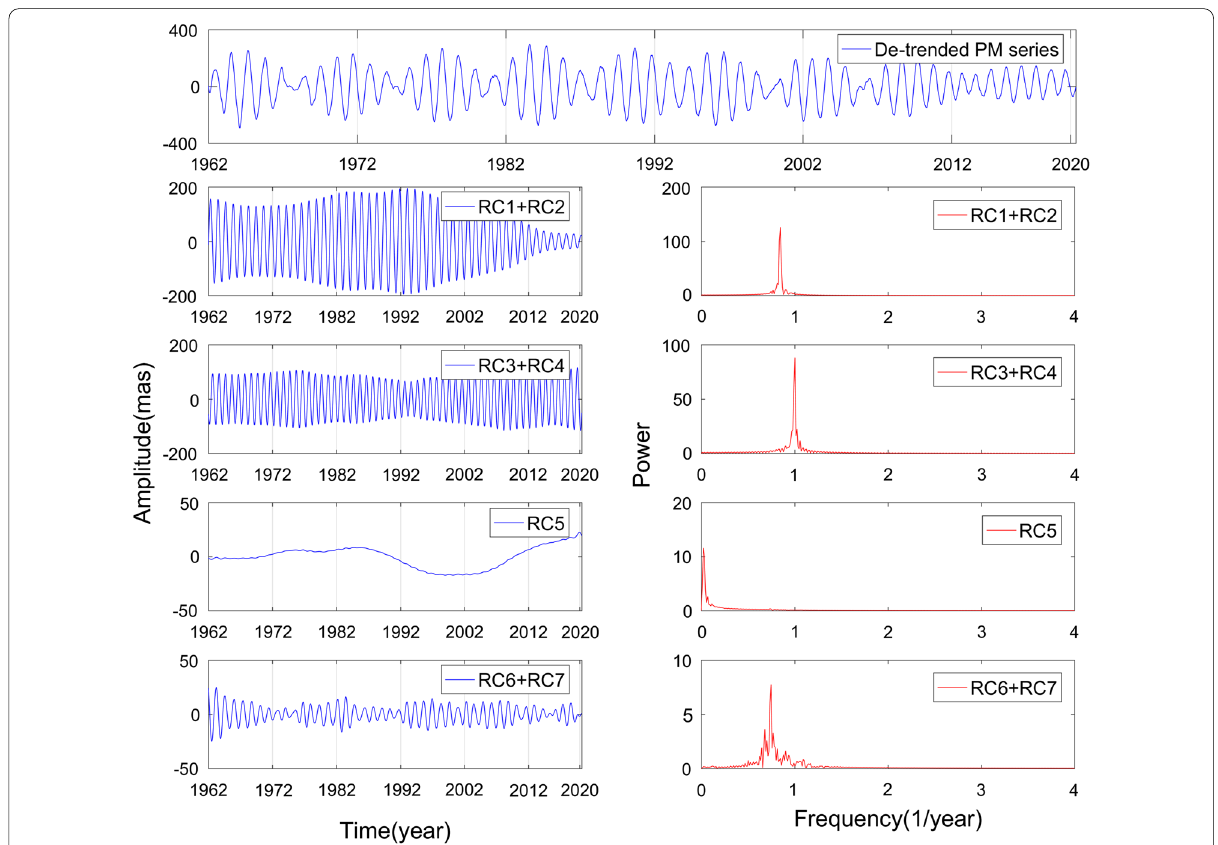
Fig. 3 RCs in the X-direction of PM and its perform power spectrum